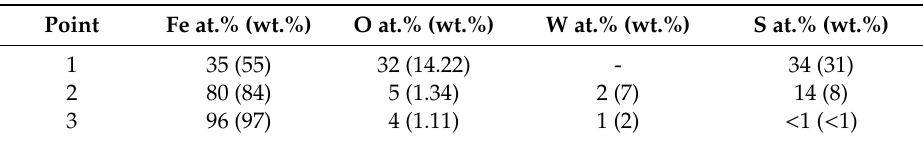
Table 8. Results of tribological tests.